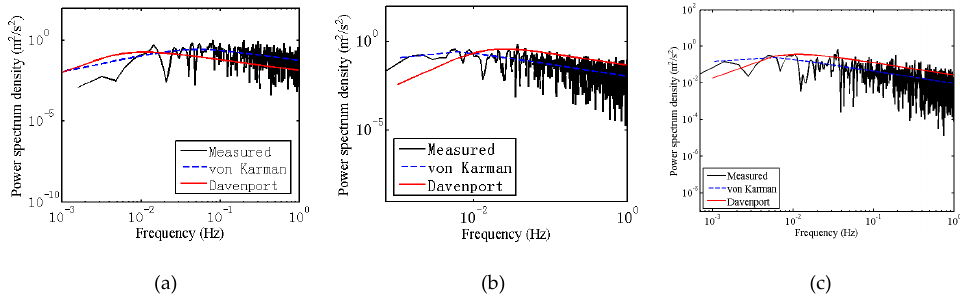
Figure 30. Power spectra of the longitudinal wind component for different time interval at ( a ) 10 m, Figure 31. Power spectra of the longitudinal wind component at ( a ) 10 m, ( b ) 80 m, and ( c ) 100 m.